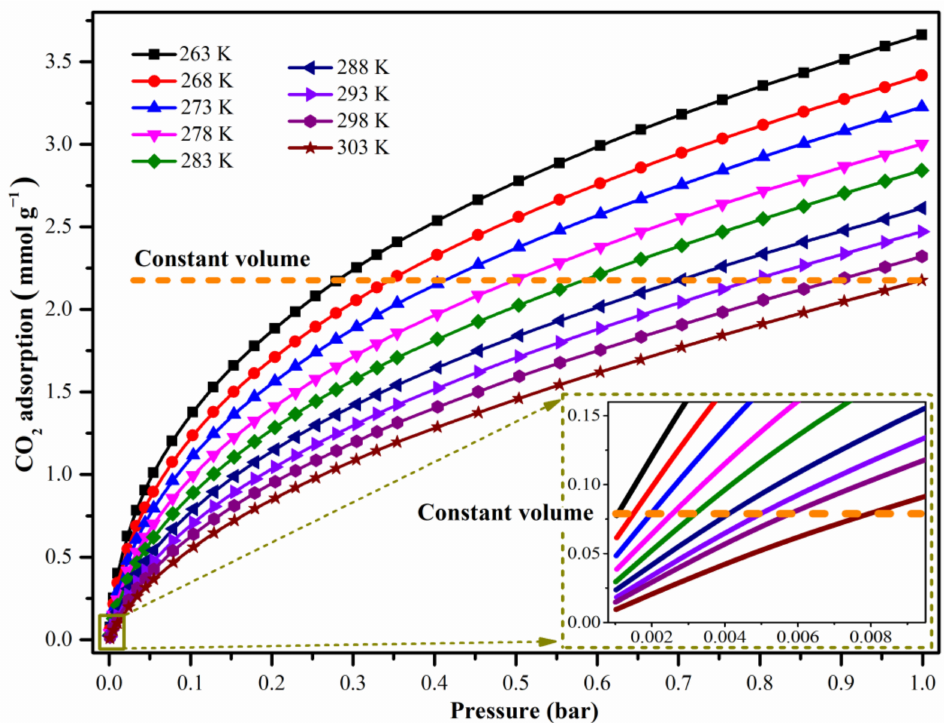
Figure 7. CO 2 isotherms of carbon microfibers calcined at 1223